Question: Express in one sentence what the figure is showing.
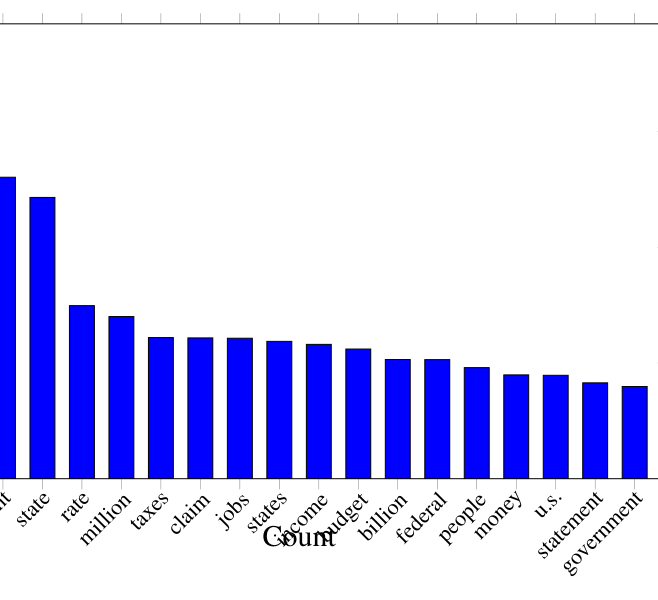
Answer: Frequency of vocabulary in FIN-FACT dataset.